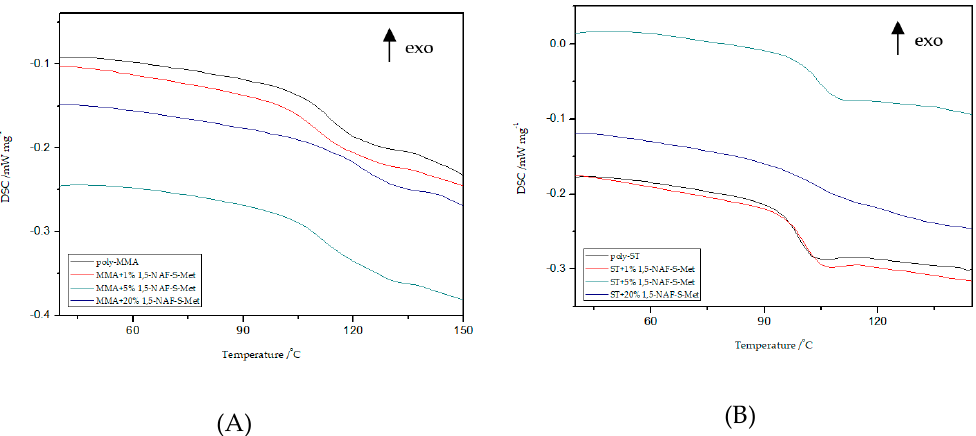
Figure 7. Influence of various addition of 1,5-NAF-S-Met on the glass transition temperature (T g ) values of MMA- ( A ) or ST- based ( B ) polymers.